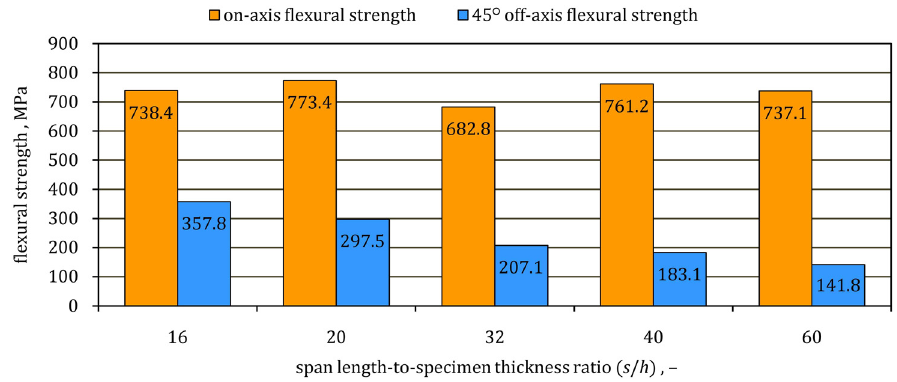
Figure 9: Comparison of the fl exural strength of the on - axis and 45° o ff - axis specimens at various values of ( s / h )